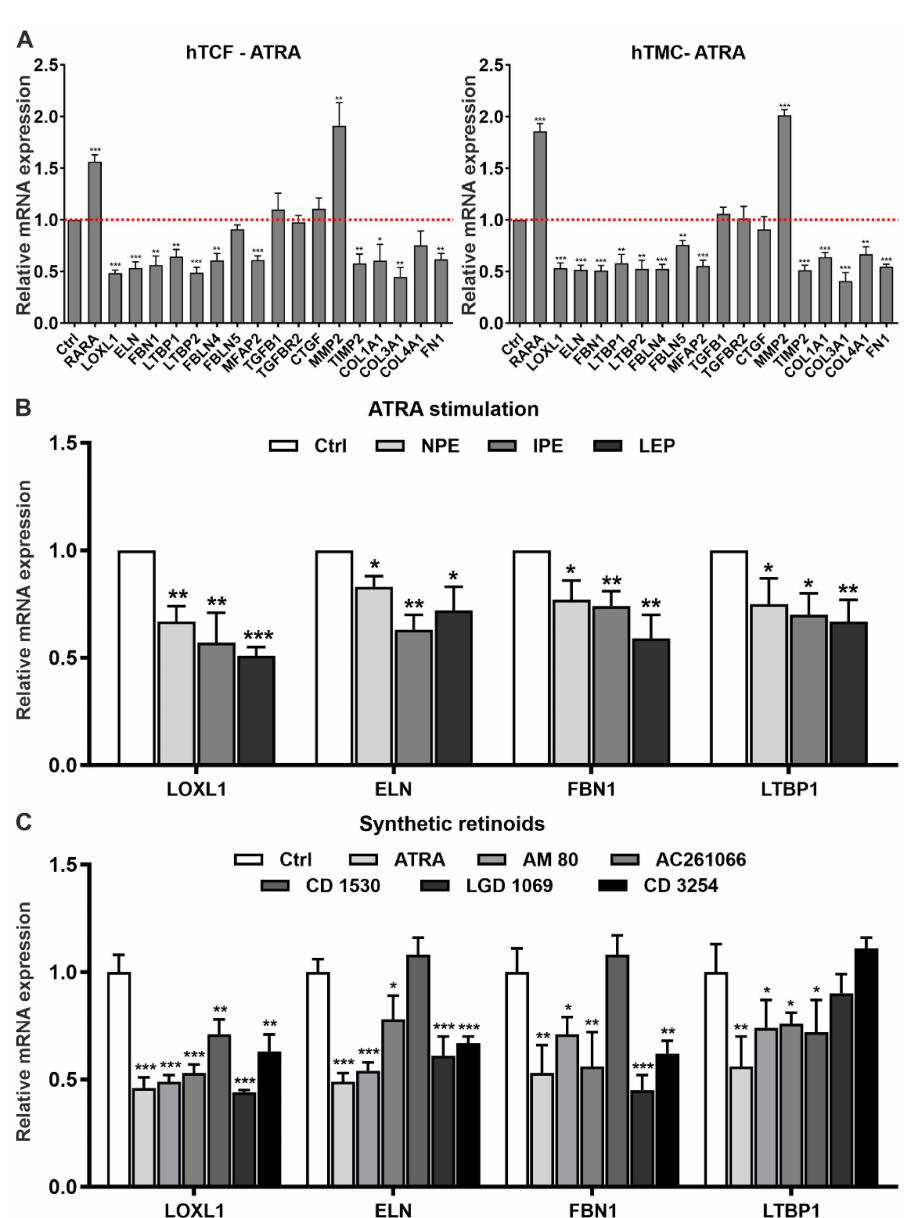
Figure 7. Effects of retinoic acid signaling activation on matrix synthesis in PEX-relevant cell types. ( A ) Quantitative real-time PCR analysis of RARA (retinoic acid receptor alpha), LOXL1 (lysyl oxidase-like 1) , ELN (elastin), FBN1 (fibrillin-1), LTBP1 (latent transforming growth factor beta binding protein 1), LTBP2 , FBLN4 (fibulin-4), FBLN5 , MFAP2 (microfibril associated protein 2), TGFB1 (transforming growth factor beta 1), TGFBR2 (transforming growth factor beta receptor 2), CTGF (connective tissue growth factor), MMP2 (matrix metalloproteinase 2), TIMP2 (tissue inhibitor of metalloproteinases 2), COL1A1 (collagen type 1 alpha 1), COL3A1 , COL4A1 , and FN1 (fibronectin-1) mRNA in human Tenon’s capsule fibroblasts (hTCF) (n = 4) and trabecular meshwork cells